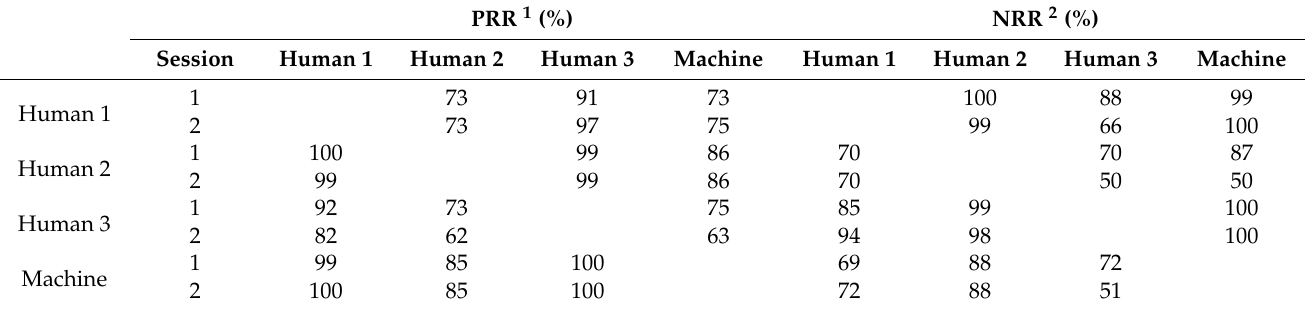
Table 4. PRR and NRR values calculated between each human rater and the machine.